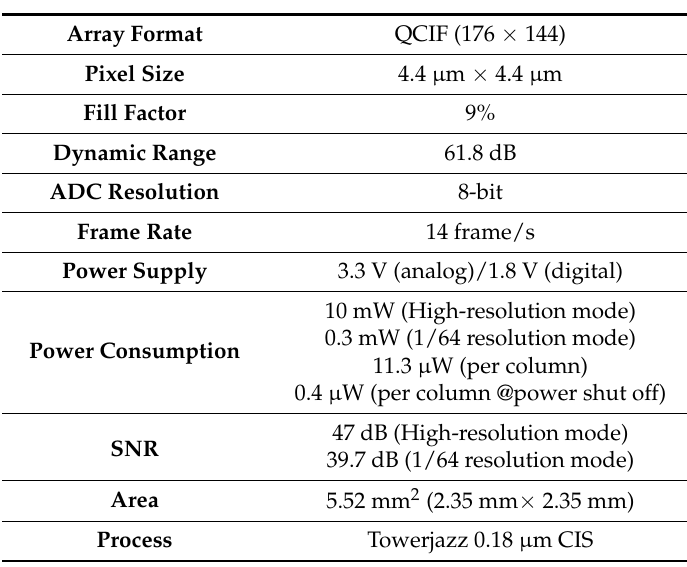
Table 1. Performance summary of the proposed CIS.